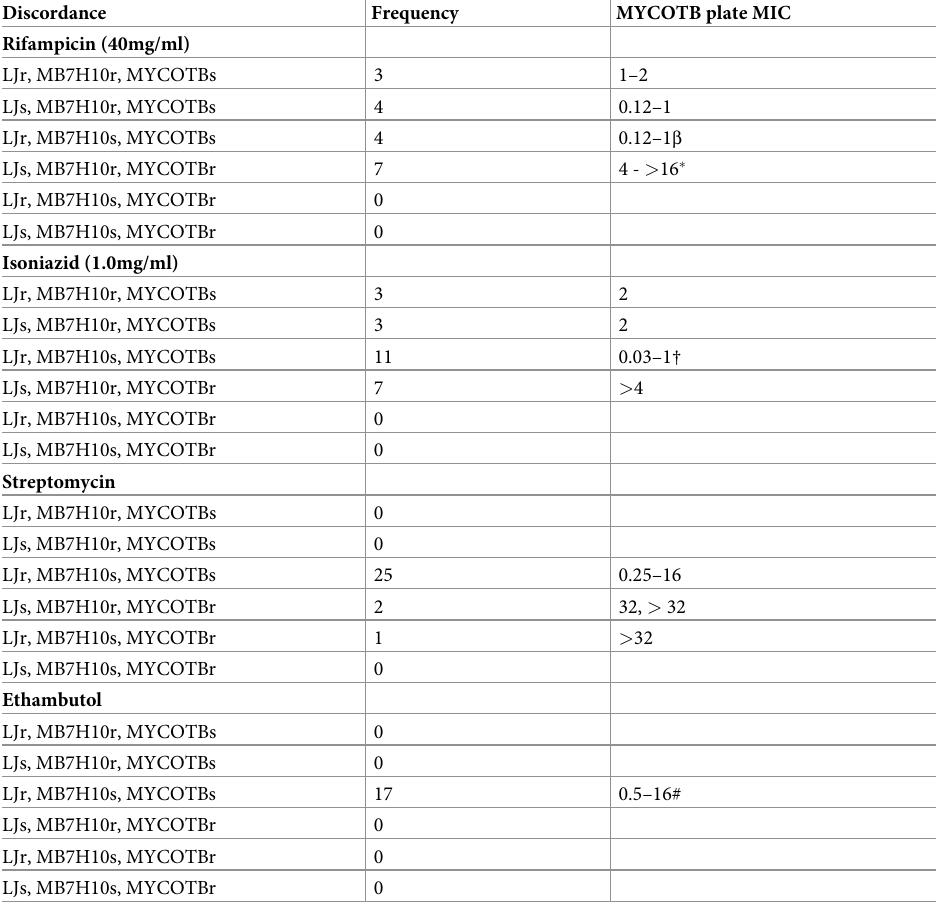
Table 2. Method discordances and the MYCOTB plate MICs. Discordance Frequency